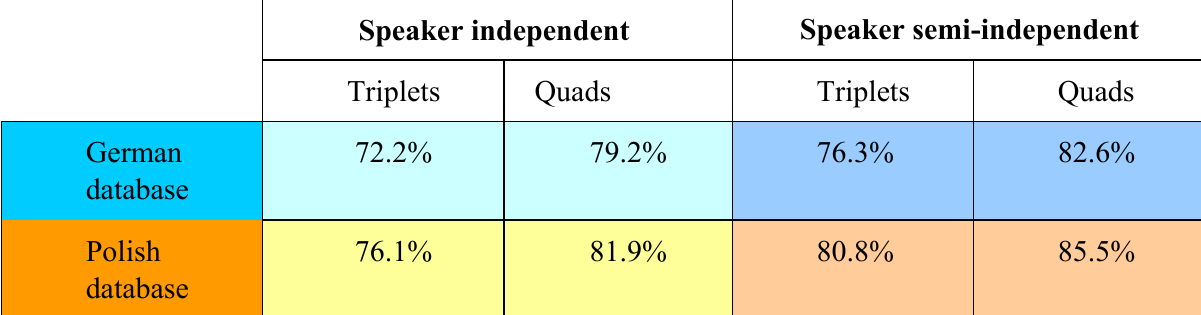
Table 3. Emotion classification results with three- and four-element feature sets.